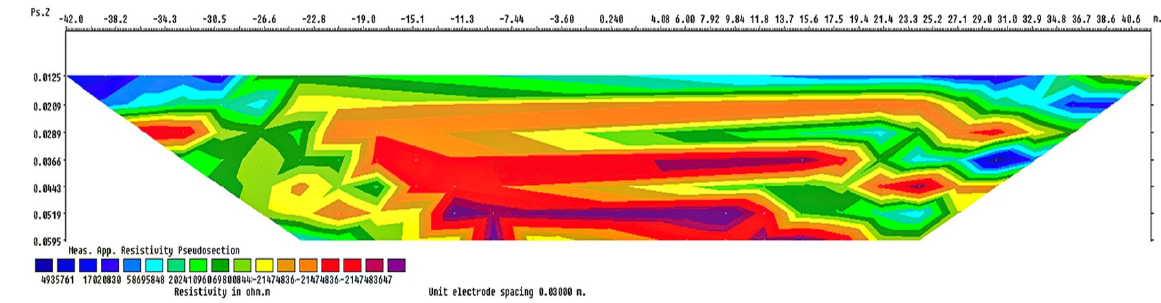
Figure 5. Surface electrical resistivity of a marble block.